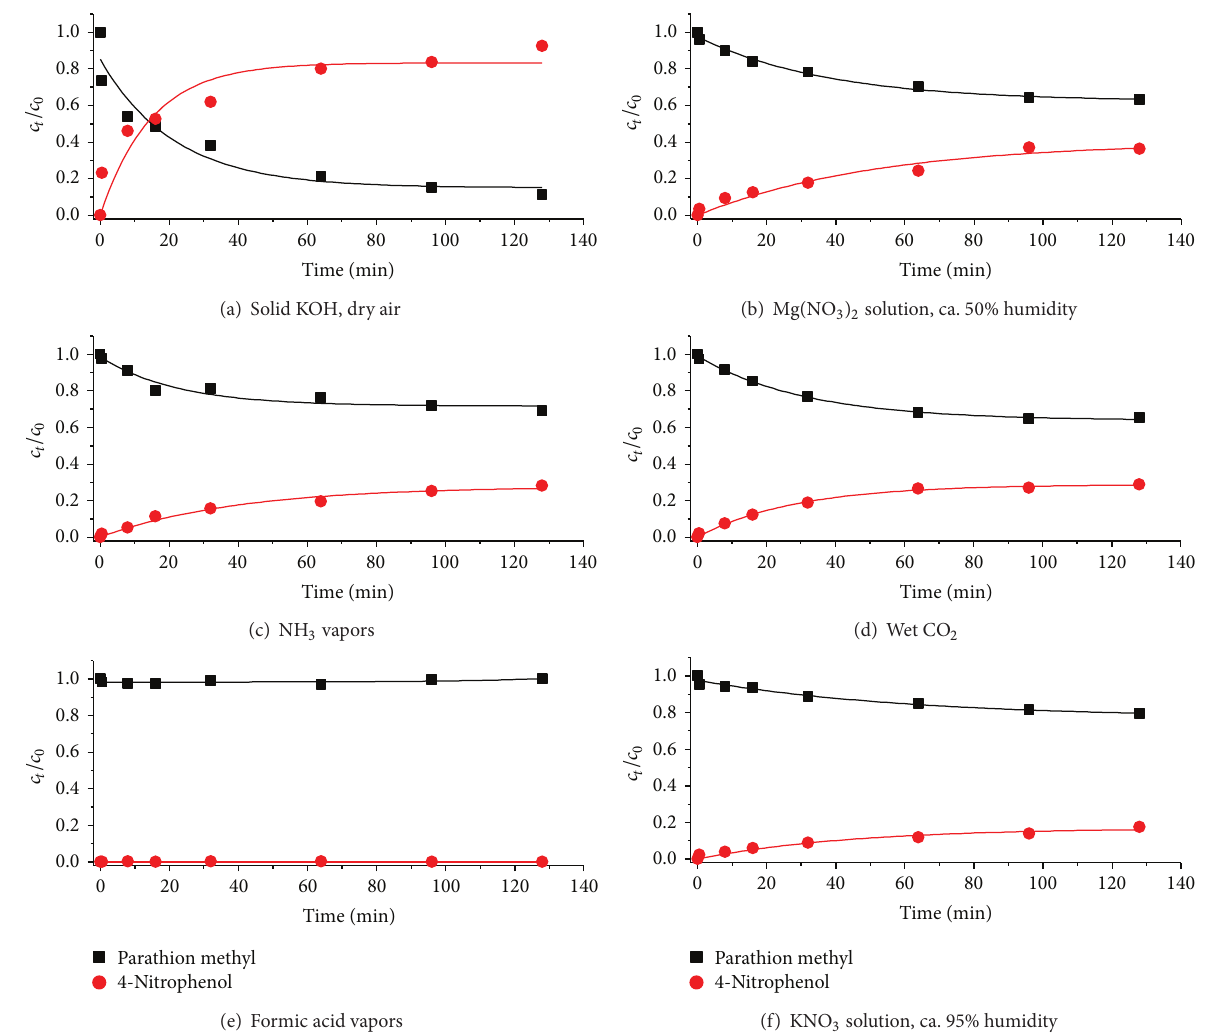
Figure 10: Degradation of parathion methyl with cerium oxide stored in dry air (a), wet air with 50% humidity (b), NH 3 vapors (c), wet CO 2 (d), formic acid vapors (e), and wet air with 95% humidity (f).